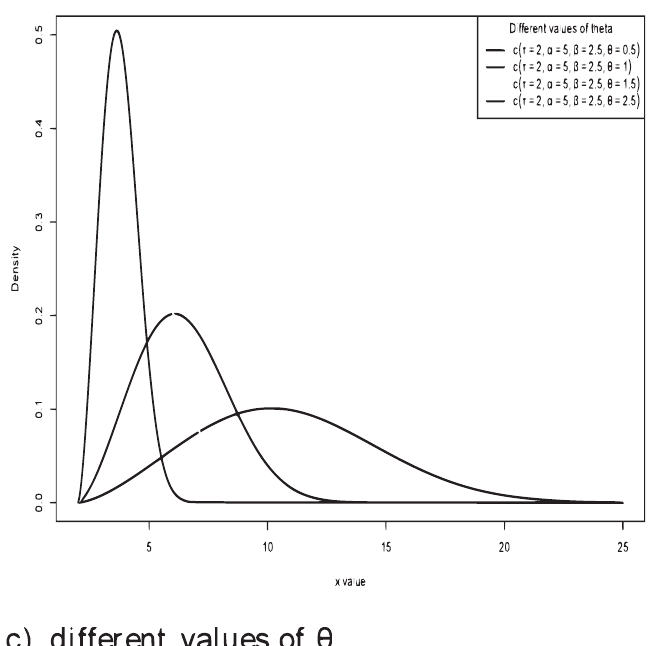
Fig 1. PDF of W-TEXPD for different values of α , β and θ